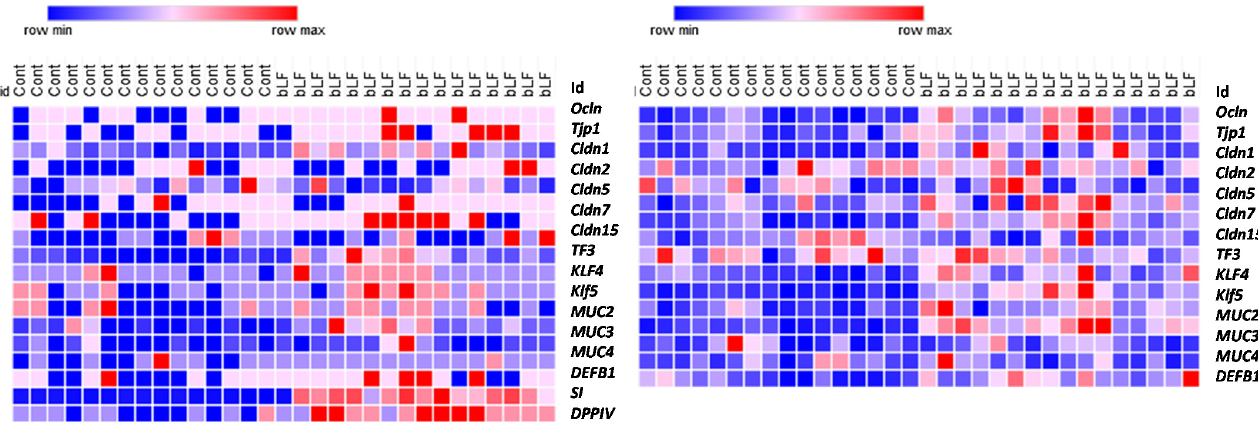
Figure 4. Heatmaps showing different levels of expression of gene coding for proteins involved in intestinal barrier function between pups recovered from mothers ingesting or not ingesting bLF. Color change from blue to red represents genes expression from low to high (16 pups were included in each